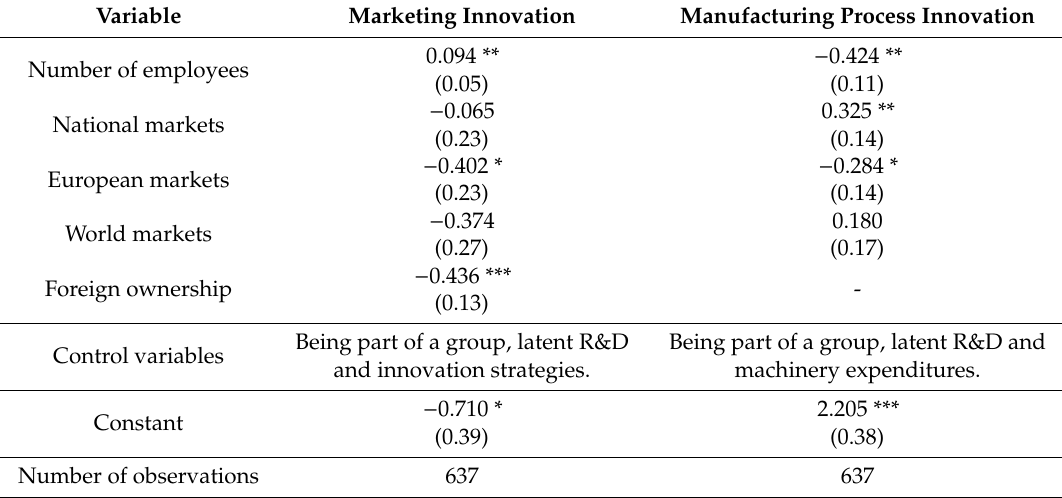
Table 4. The bivariate Probit model of marketing and manufacturing process innovations.